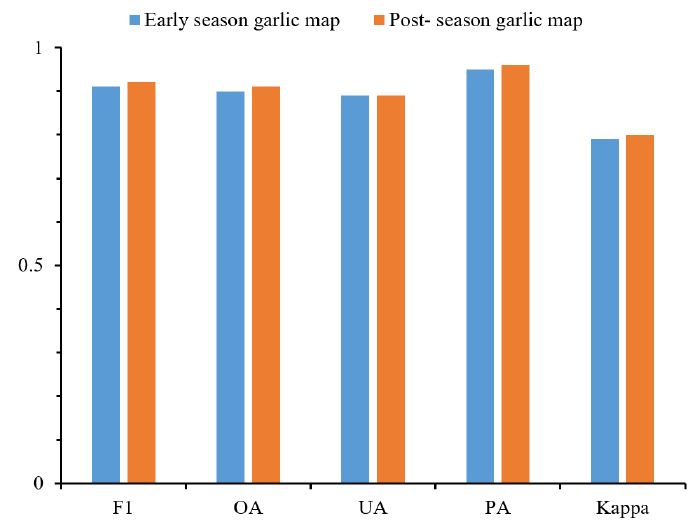
Figure 8. Comparison of accuracy between early-season map and post-season map.